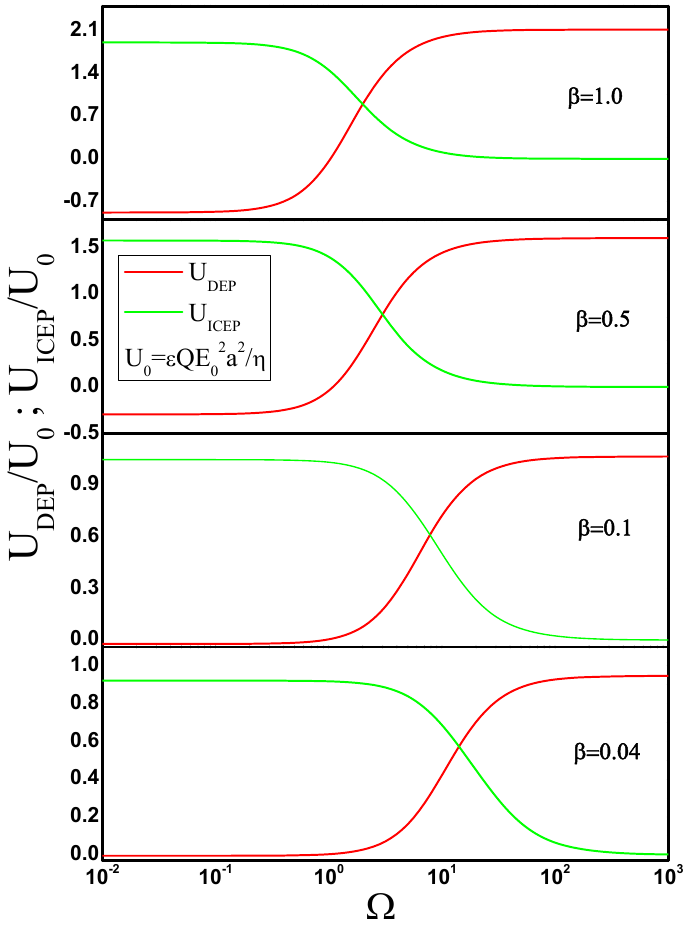
Figure 5. Dipolophoresis of a metal cylinder as a function of angular frequency of the applied ac field. Results are shown for four different values of the cylinder aspect ratio β = b / a . The velocity is a 2 / η non-dimensionalized with U 0 = ε QE 2 0